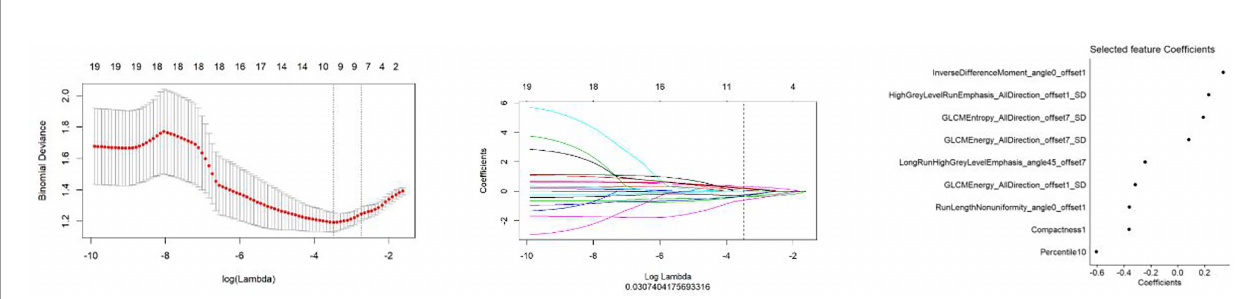
FIGURE 1 | The establishment of LASSO regression model. (Left) Curve of binomial deviation of MR-derived radiomic model varying with parameter l . The vertical axis is binomial deviation. The horizontal axis represents the log ( l ) value. The number above represents the number of selected features, and the l at the minimum binomial deviation of the model is the optimal value (the curve of the image group characteristic coef fi cient of the vertical dotted line). (Middle) MR model changing with l . The number above indicates the number of features fi ltered out. (Right) Imaging features screened by MR model.